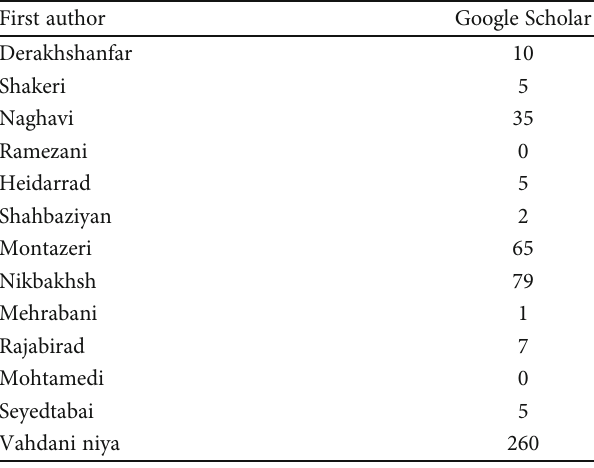
Table 3: Number of citations of Google